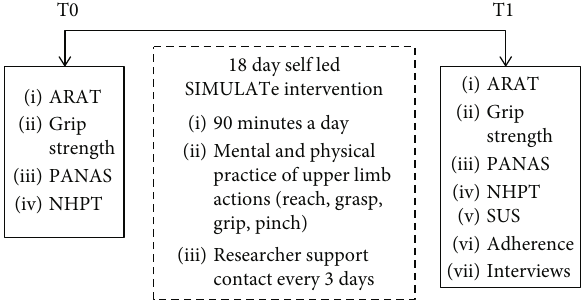
Figure 3: A schematic of the study design. Outcome measures include the action research arm test (ARAT) [54, 55], grip strength, positive and negative assessment scale (PANAS) [56], nine hole peg test (9-HPT), System Usability Scale (SUS) [57], and adherence and semistructured